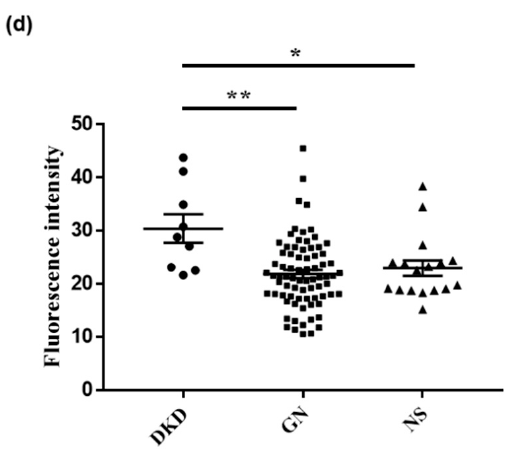
Figure 2. Fluorescence images of urine after incubation with DPP-HMRG. Representative fluorescence images of urine obtained from patients with diabetic kidney disease ( a ), glomerulonephritis ( b ), and nephrosclerosis ( c ) after incubation with DPP-HMRG. Urine from patients with diabetic kidney disease showed a significantly high fluorescence intensity compared to the other groups ( d ). * p < 0.05, ** p < 0.01.